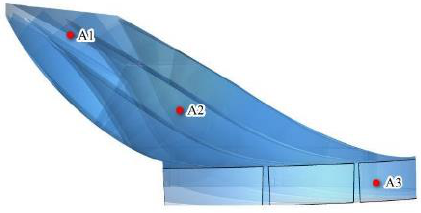
Figure 11. Monitoring points in the channel.